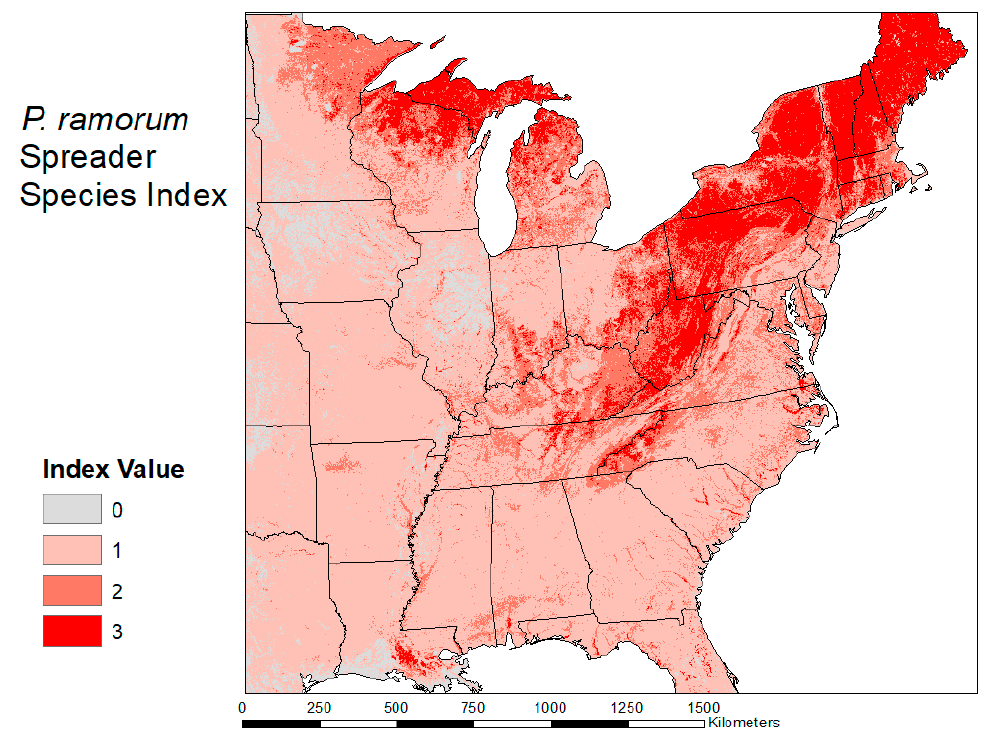
Figure 4. The index based on BA of P. ramorum spreader species. Resolution: 250 m.